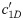
Optimal duty factors and pair lag vs magnitude of force rate cost coefficient (c1D′) at UH′=0.39.As force-rate penalties increase, duty factor also increases. Optimal duty factors in fore and hind remain close for all c1D′. Pair lag decreases slowly with force rate penalty. At no point do optimal duty factors and pair lags simultaneously match the empirical values (dotted lines) from [37]. The morphological data is based on a Dalmation from [37] (see also Fig 5B).